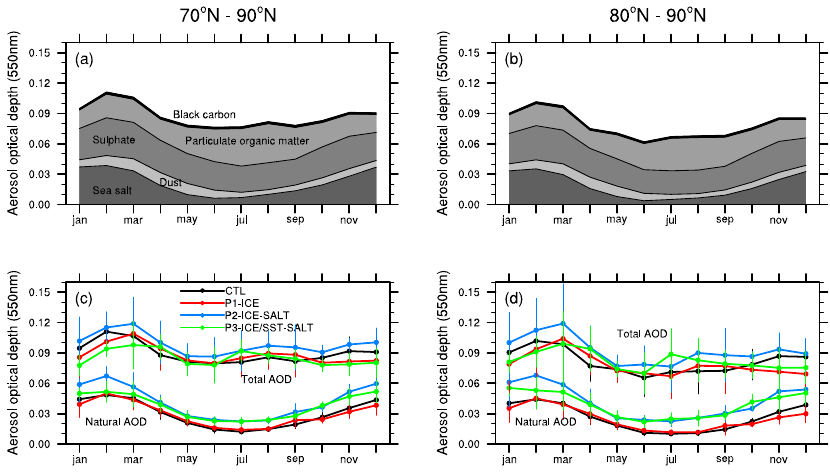
Fig. 10. (a) , (b) Contribution from the five components of the aerosol burden (black carbon, particulate organic matter, sulphate, mineral dust and sea salt) to the total AOD for the CTL simulation. (c) , (d) modeled Arctic natural AOD (550nm) and total AOD (550nm) with averages taken over ocean grid points only for the final five years of the model integrations.